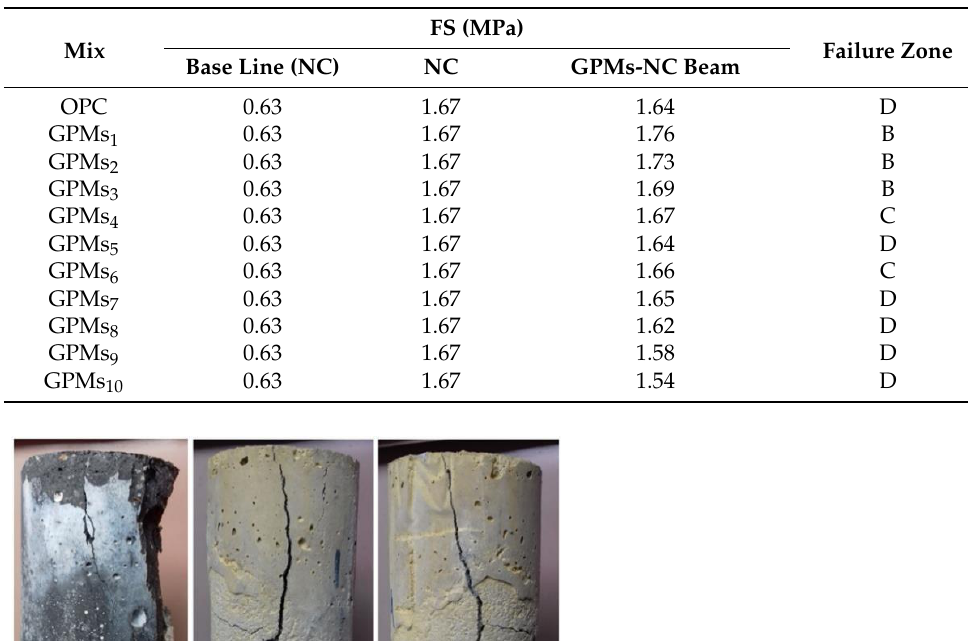
Table 1. GPMs–NC composite beam FS and failure zone.